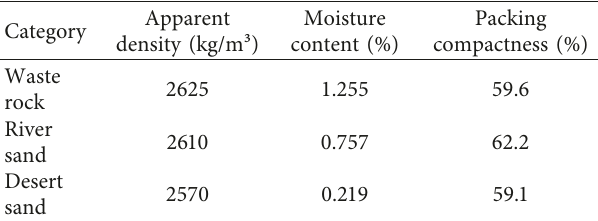
Table 1: Basic physical parameters of filling aggregate.